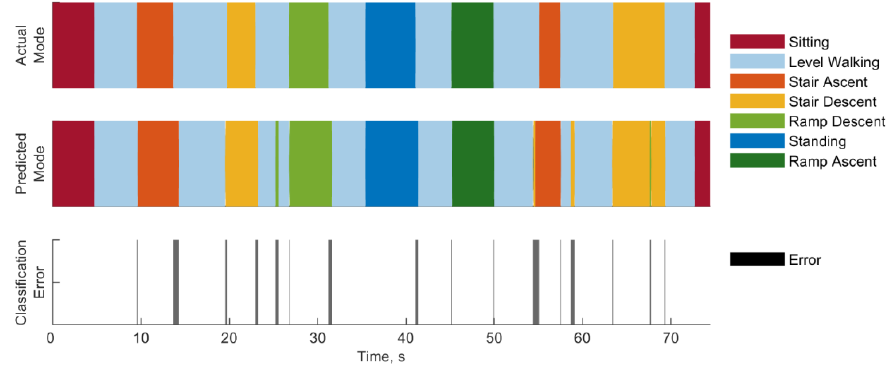
Figure 6. Classification errors for a representative subject, AK5.